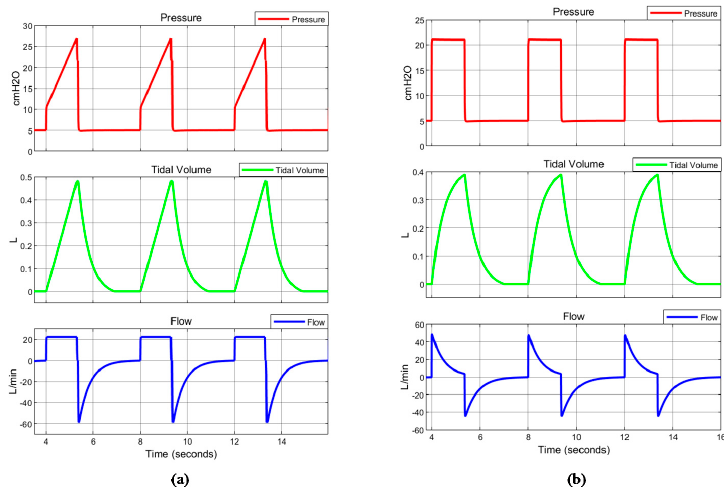
Figure A4. Case 2. Simulation results in terms of pressure, tidal volume, and inspiratory flow: ( a ) VC − CMV mode, ( b ) PC − CMV mode.